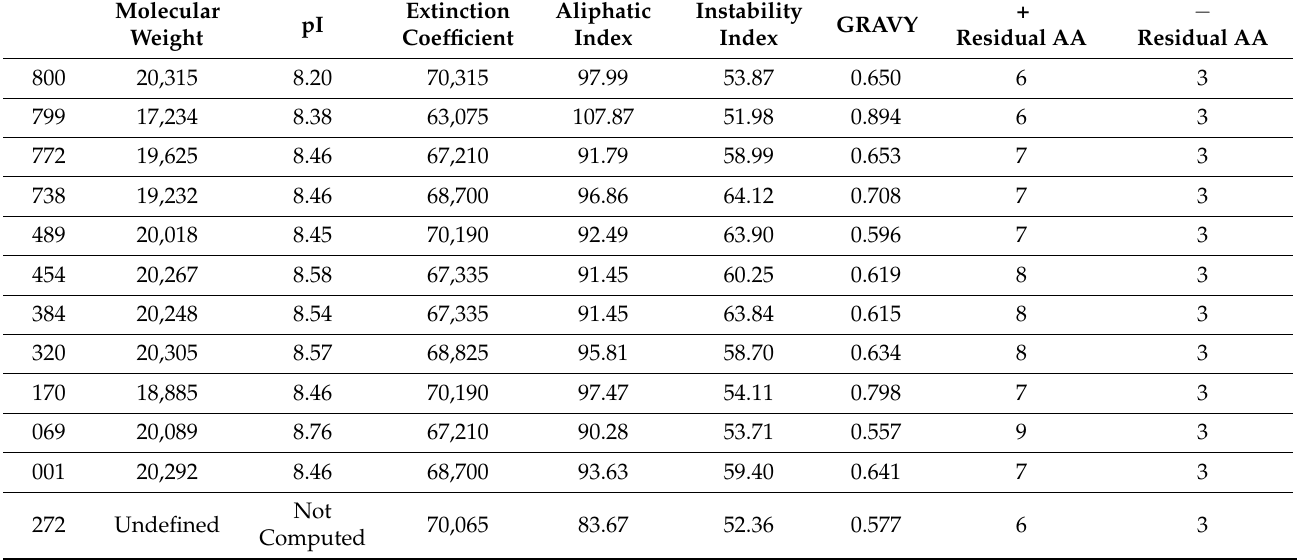
Table 5. Molecular weight, theoretical isoelectric point (pI), extinction coefficient, aliphatic index, instability index, grand average of hydropathy (GRAVY), and total number of positive and negative residues of S